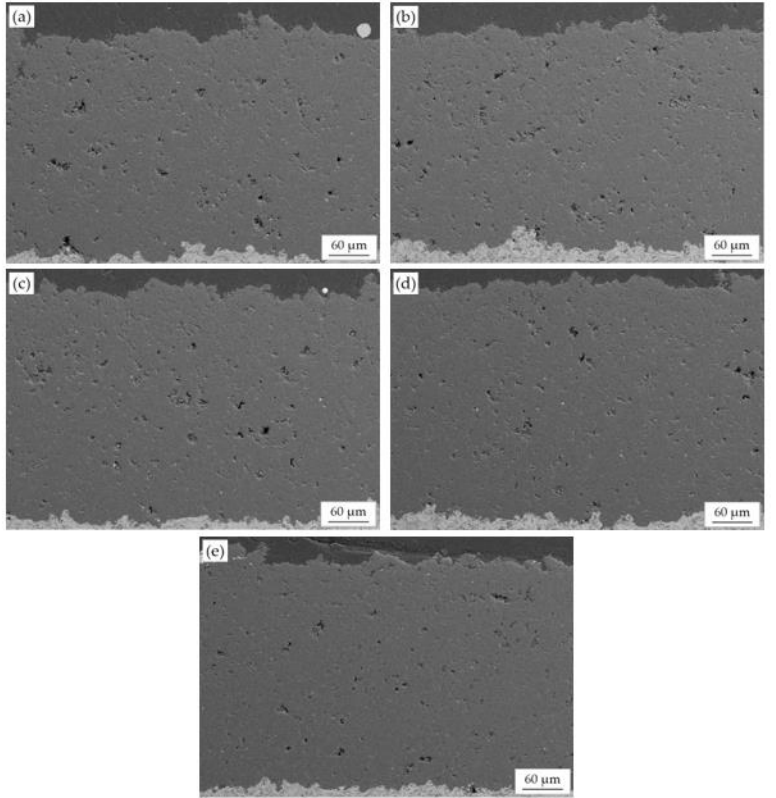
Figure 6. Microstructures of the Al 2 O 3 coatings with different MgO doping contents: ( a ) 0 wt.%; ( b ) 1 wt.%; ( c ) 3 wt.%; ( d ) 5 wt.%; ( e ) 10 wt.%.